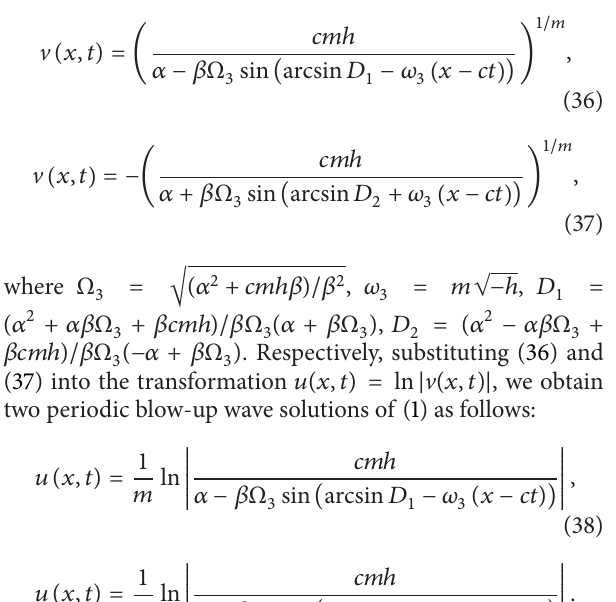
(vi) When 𝑛 = 𝑚, ℎ > 0 and 𝑚 is odd, (14) can be